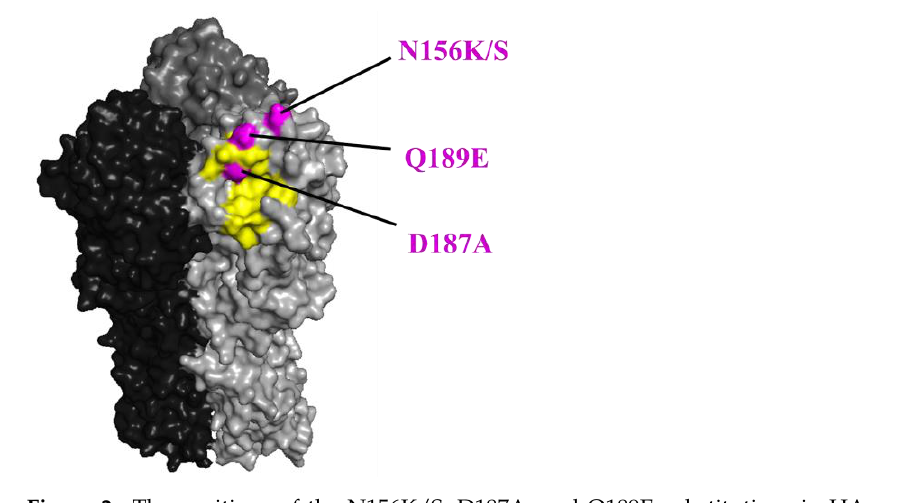
Figure 2. The positions of the N156K/S, D187A, and Q189E substitutions in HA are shown in magenta. The positions (H1 numbering) are shown on the HA structure of A/California/04/2009 (PDB ID: 3ubn). The amino acids that are important for receptor binding are colored yellow.